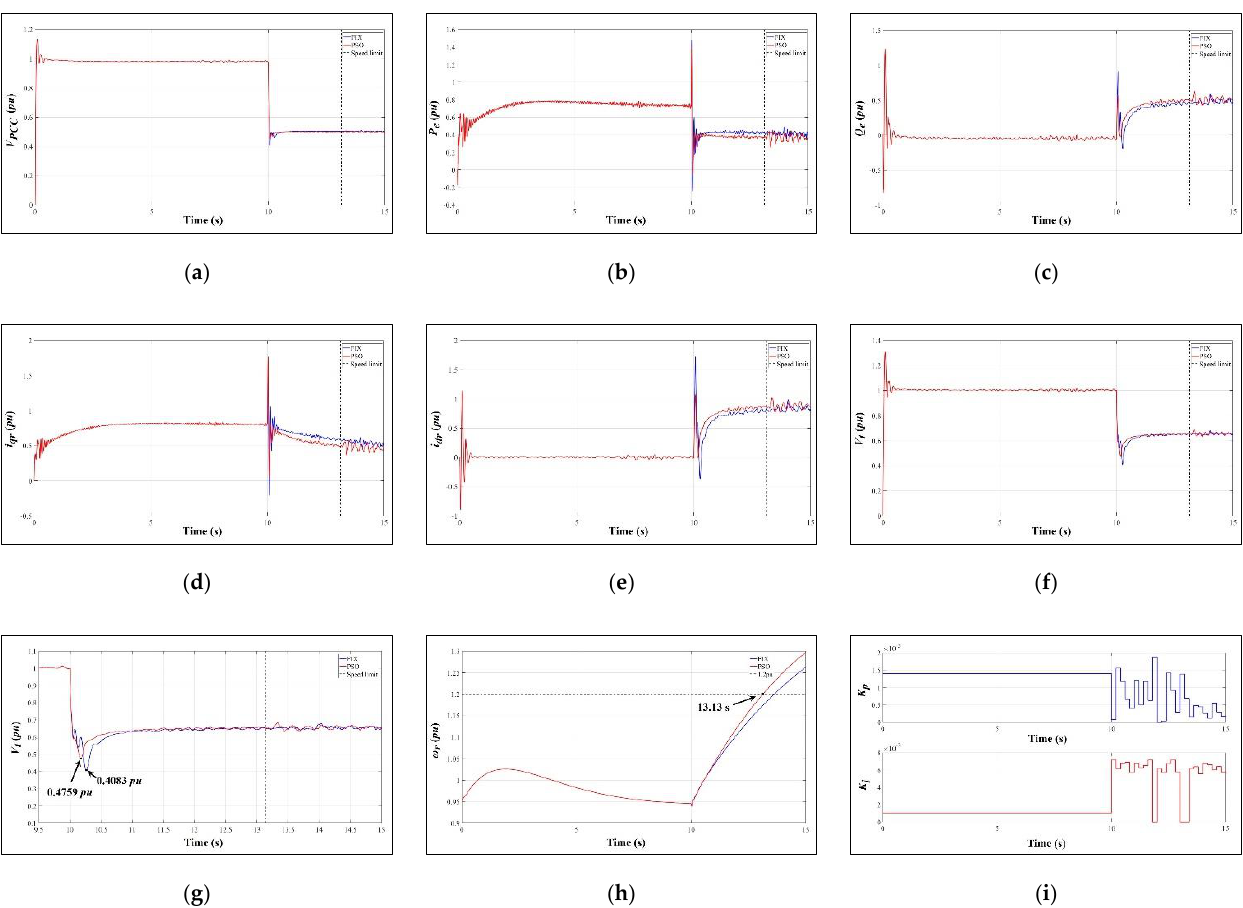
Figure 10. Dynamic response curve for fixed-gain PI de-loaded controller and PSO self-tuning de − loaded controller when the grid is subject to a fault of 0.5 pu . ( a ) Voltage at point of common coupling (PCC). ( b ) Wind farm real power. ( c ) Wind farm reactive power. ( d ) q − axis rotor current. ( e ) d − axis rotor current. ( f ) Wind farm terminal voltage. ( g ) Enlarged version of the terminal voltage. ( h ) Generator rotor speed. ( i ) PSO controller gains K p and K i .